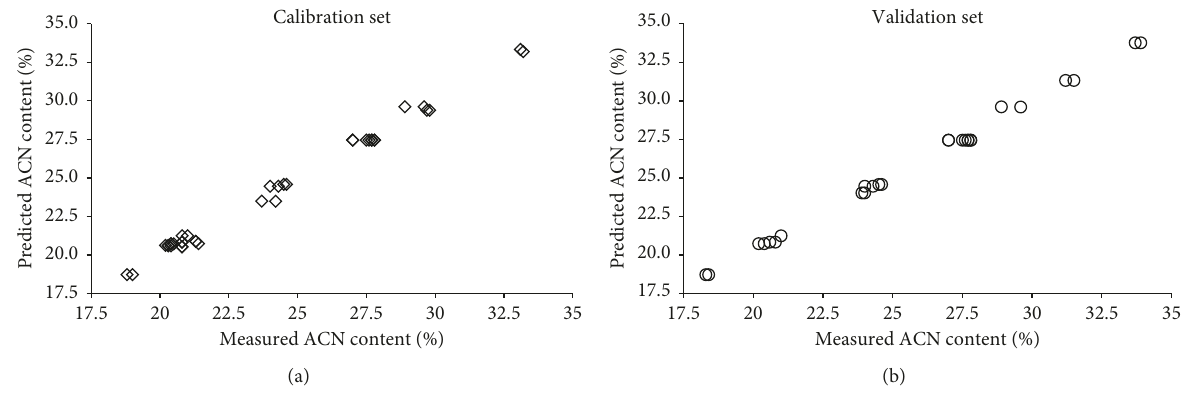
Figure 2: Reference measured versus predicted value of calibration (a) and validation (b) samples for total anthocyanins (%) in bilberry extracts using the PLS model. Table 1: Summary of the NIRS calibration model